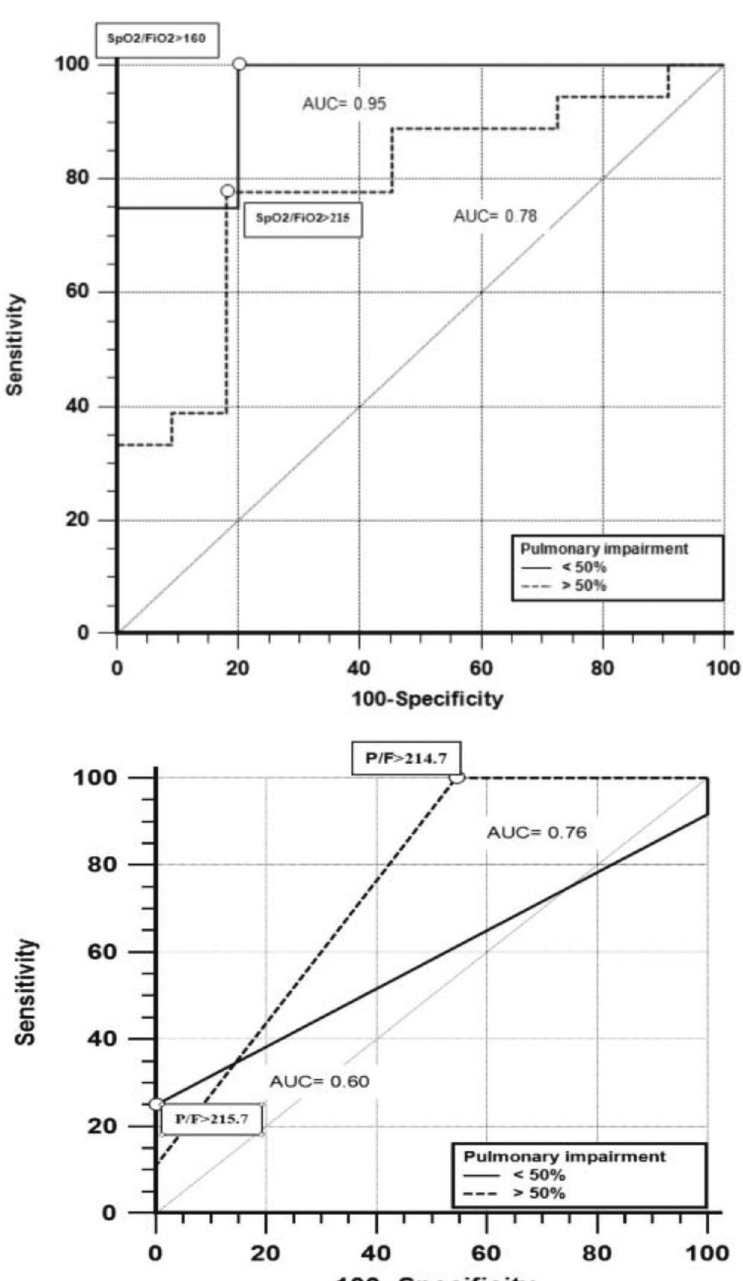
Figure 4 - ROC curve analysis of the effectiveness of using SpO 2 /FiO 2 and PaO 2 /FiO 2 for predicting the need for endotracheal intubation based on pulmonary impairment. The top figure represents SpO 2 /FiO 2 , and the bottom figure represents PaO 2 /FiO 2